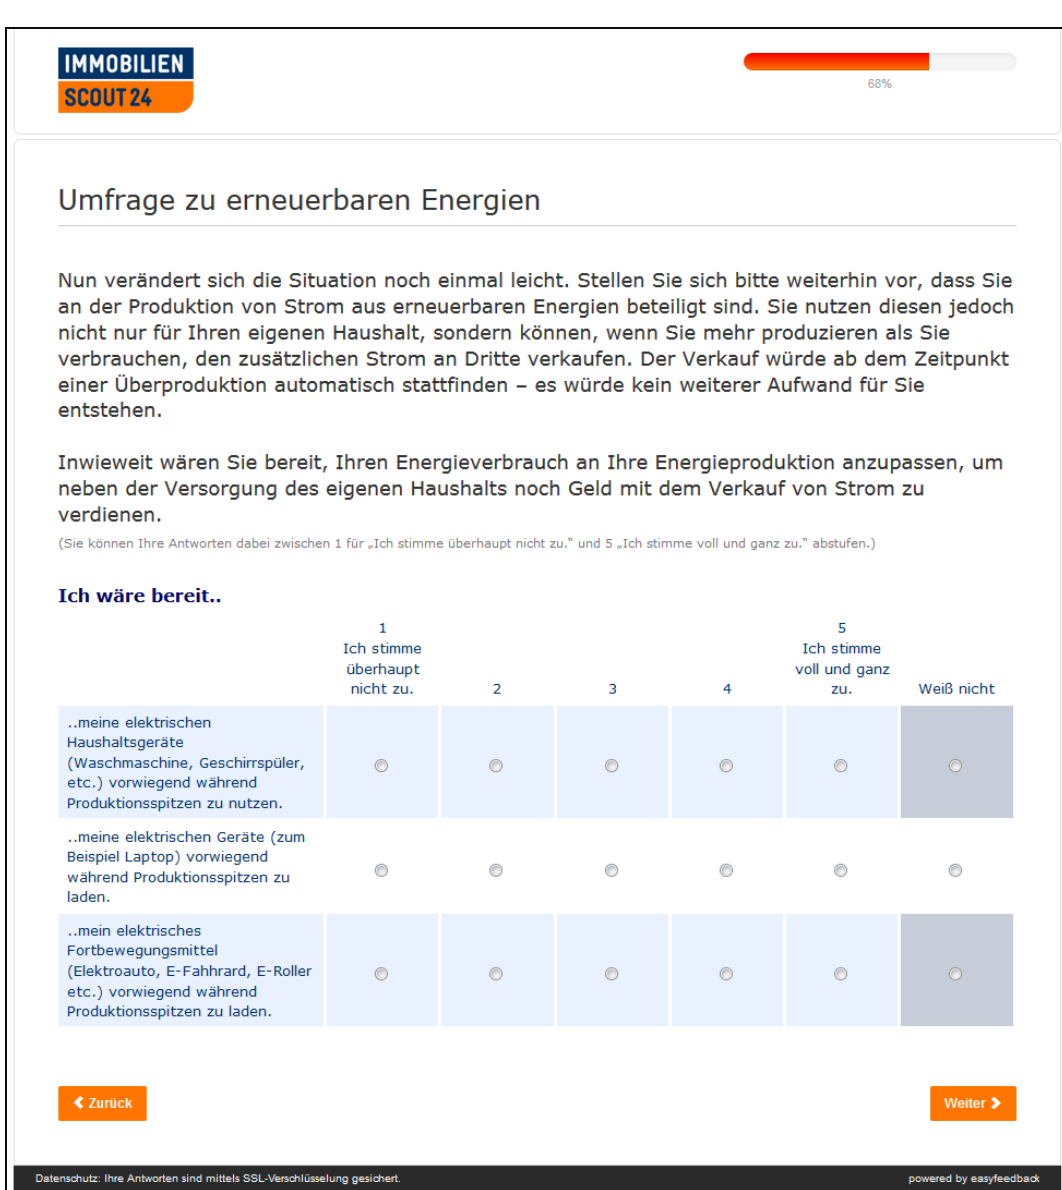
Figure A13. Screenshot of Questionnaire Page 12.